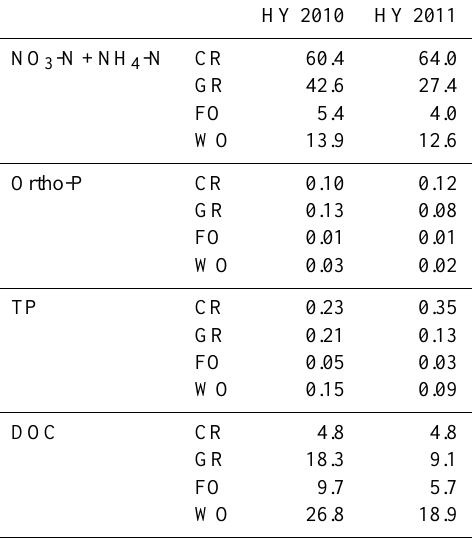
Table 1. Catchment export fluxes of nitrogen (NO 3 -N+NH 4 -N), dissolved phosphorus (Ortho-P), total phosphorus (TP), and dis- solved organic carbon (DOC). Fluxes calculated separately for the Hydrological Years (HY) 2010 and 2011 for the catchments “Crops” (CR), “Grassland” (GR), “Forest” (FO), and the “Water- shed Outlet” (WO). Calculated numbers in kgha − 1 a − 1 . HY 2010 HY 2011 NO 3 -N+NH 4 -N CR